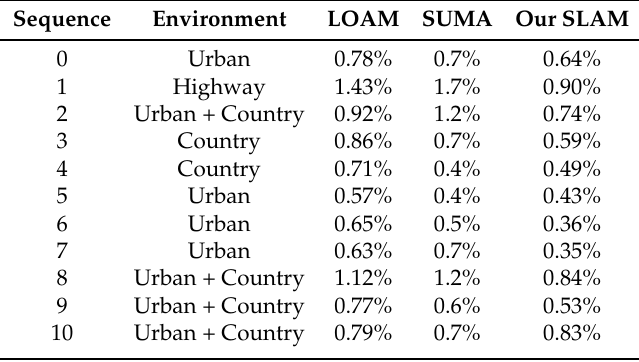
Figure 4. Sample results using the KITTI benchmark datasets. The datasets are chosen from three types of environments: highway, country and urban from left to right, corresponding to sequences 01, 03, and 07. In ( a – c ), we compare estimated trajectories of the vehicle to the GPS/INS ground truth. The mapping results are shown in ( d – f ). An image is shown from each dataset to illustrate the environment, in ( g – i ). Table 1. Results On KITTI